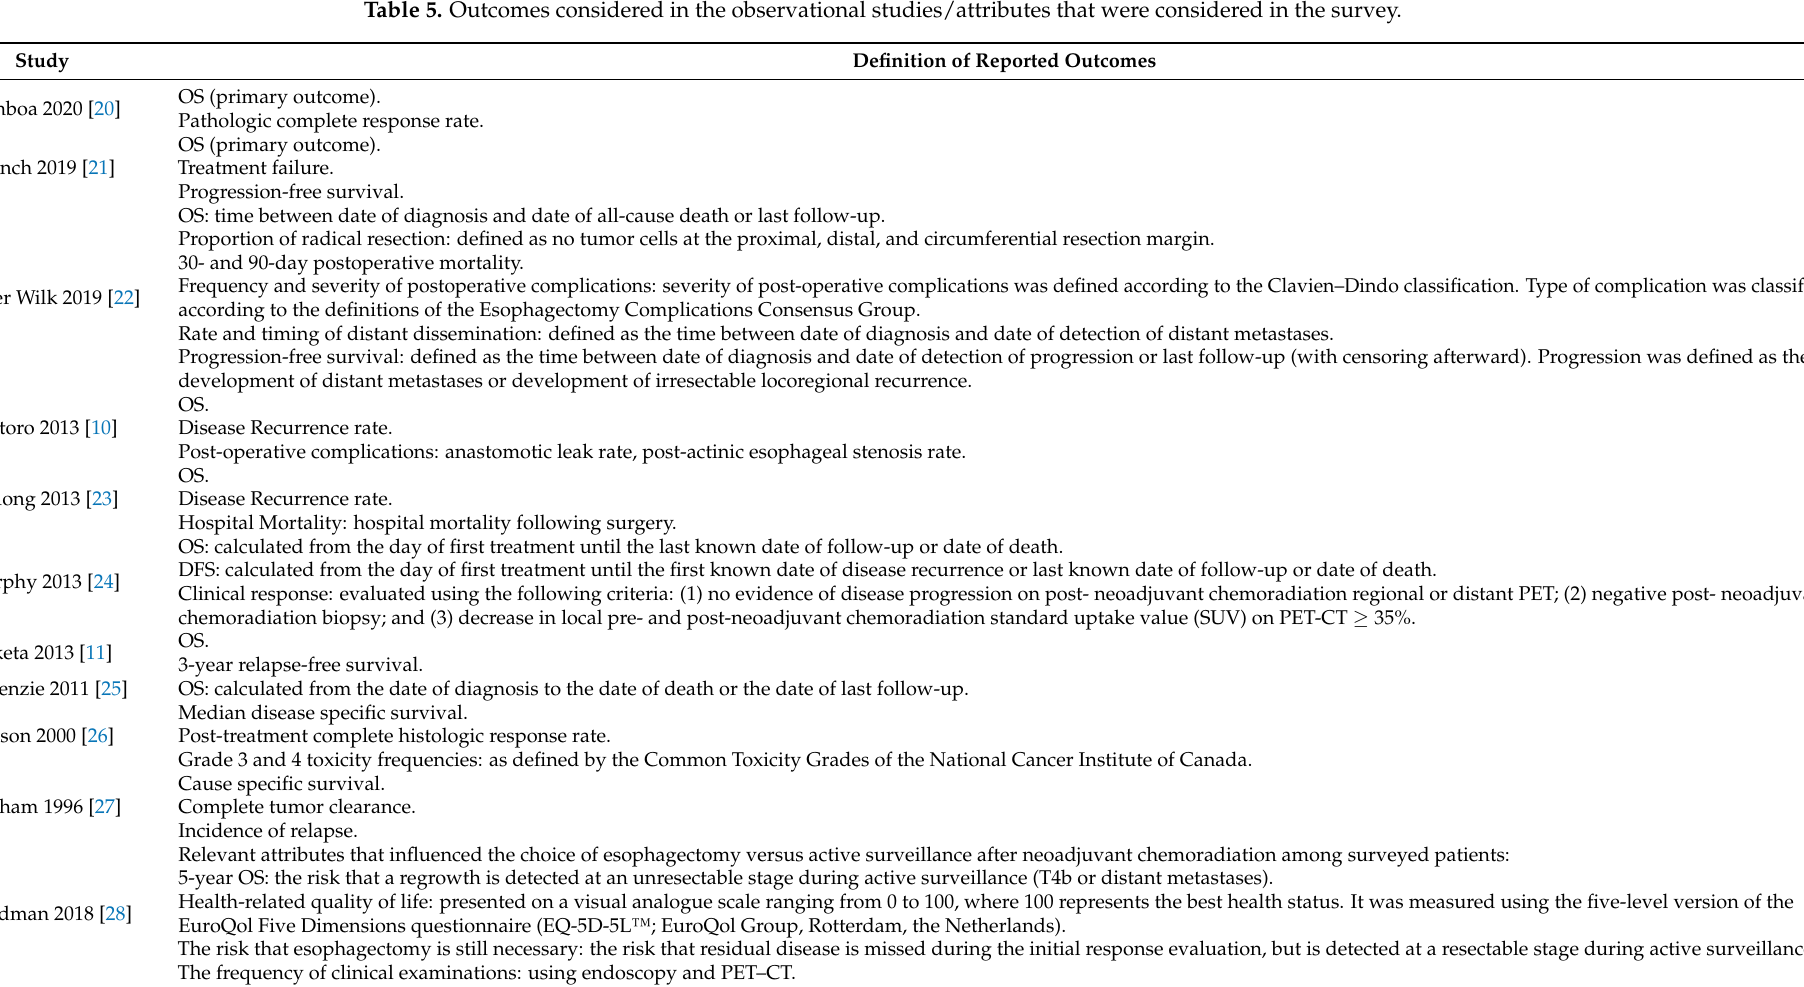
Table 5. Outcomes considered in the observational studies/attributes that were considered in the